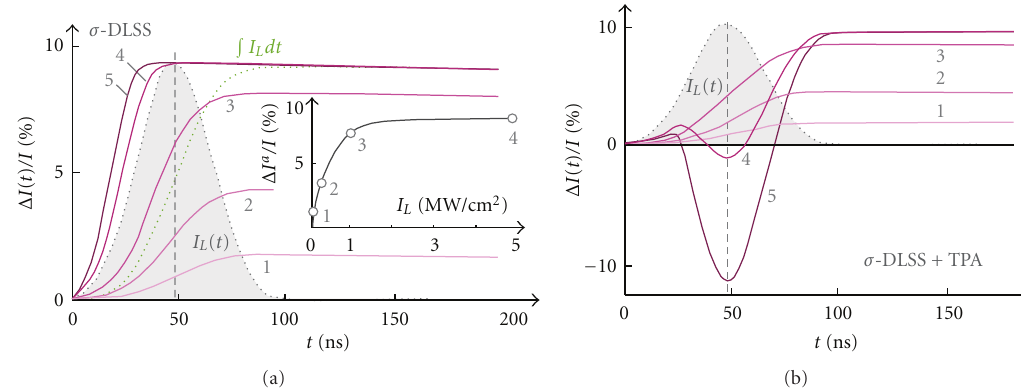
Figure 6: Calculated kinetics of σ -DLSS signals in the spectral area of impurity bleaching ( (cid:2) ω > E g − E M ) for di ff erent levels of modulation I L ; for the cases: without (a) and with account (b) of the coherent TPA contribution. (a) Δ α σ ( t ) (12) for a Gaussian laser pulse (19) with (cid:23) t Δ t = 40ns (dotted line, integrated envelope I L ( t (cid:3) ) dt (cid:3) ). Inset-corresponding LID with the numbered points for which the shown same L 0 numbered kinetics were calculated (5 − I L = 10 MW/cm 2 ). Parameters: M = 10 17 cm − 3 , σ ( ω ) = σ ∗ ( ω ) = σ ∗ ( ω L ) = 10 − 17 cm 2 , τ ∗ = 10 − 5 s, I ( ω ) = 10 21 s − 1 . (b) Similar calculations, but with adding the contribution of an opposite TPA signal ( β = 0,01cm/MW).